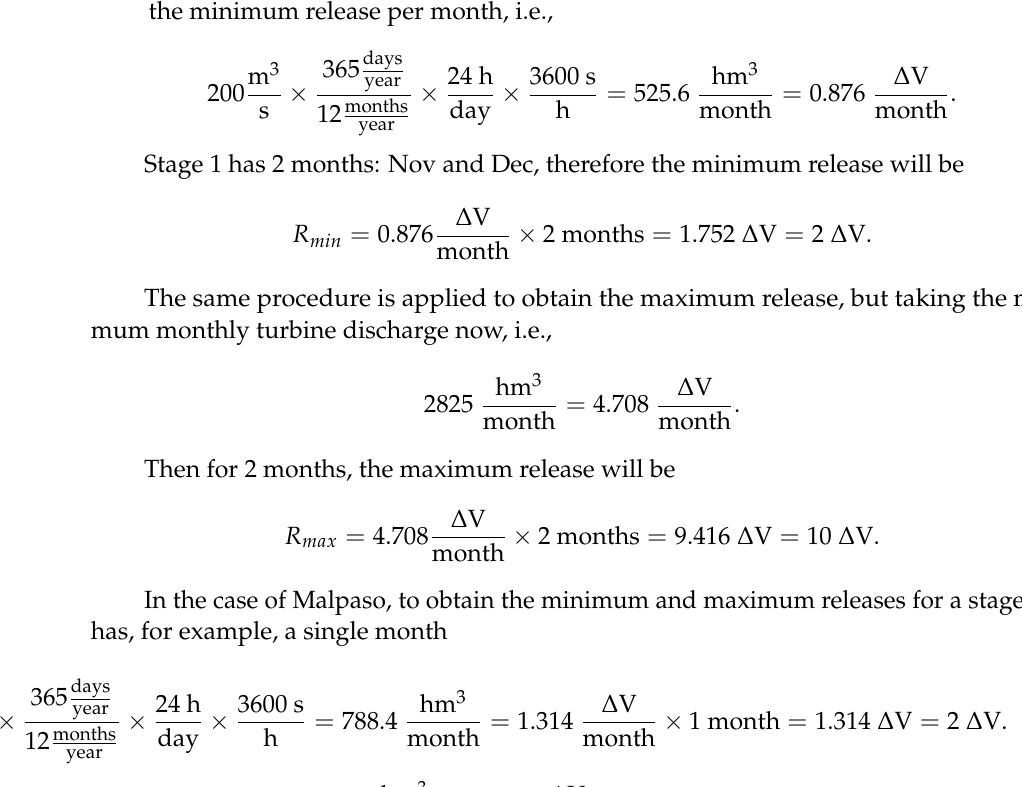
To take into account the randomness of the inflows, they are defined by a probability density function. In Figure 4 and Figure 5 the probabilities (JP in Equation (5)) asso- ciated with the historic inflows are given for each stage and each dam.